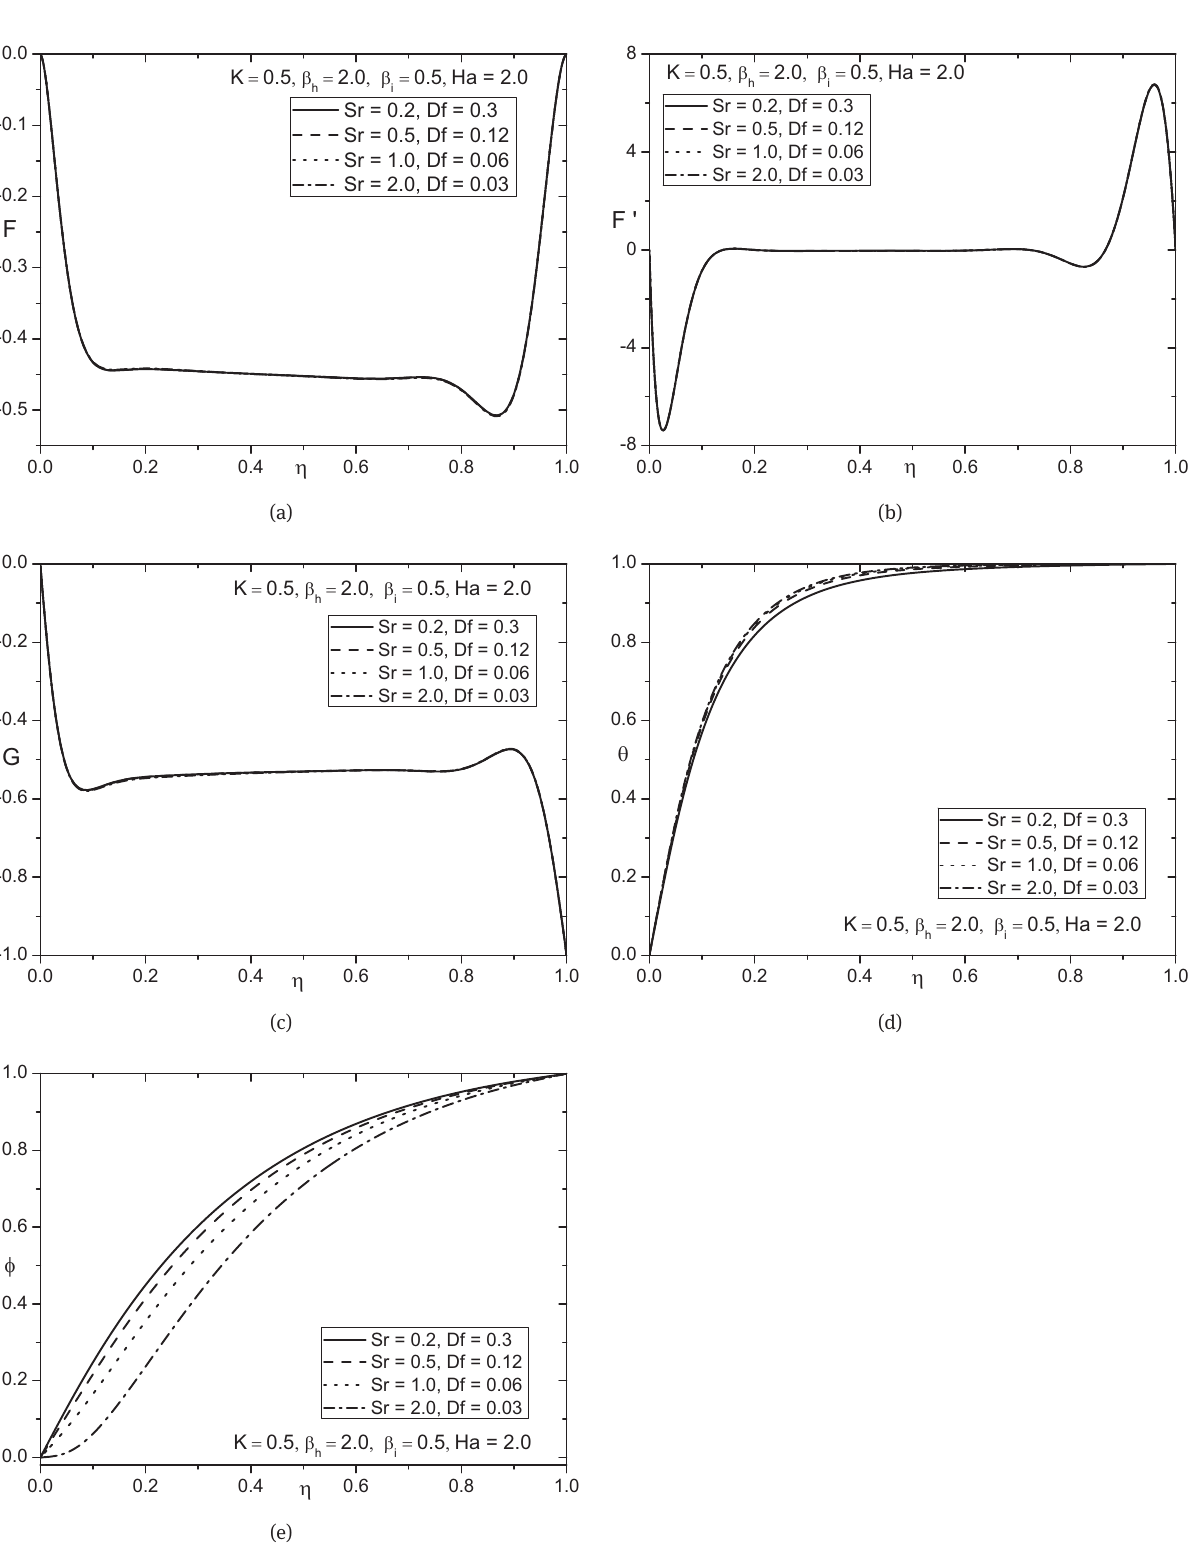
Fig. 6: Effect of Soret and Dufour number on (a) axial velocity, (b) radial velocity, (c) tangential velocity, (d) temperature, and (e) concentra- tion